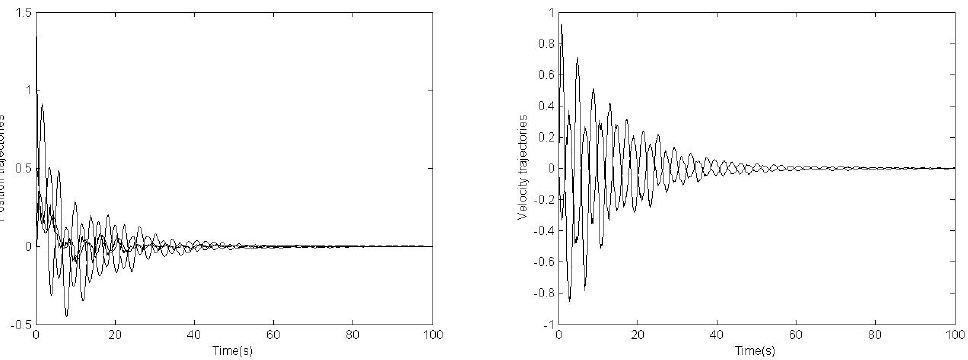
Figure 4. Trajectories of systems (1), (3), (4) with consensus algorithm (19).